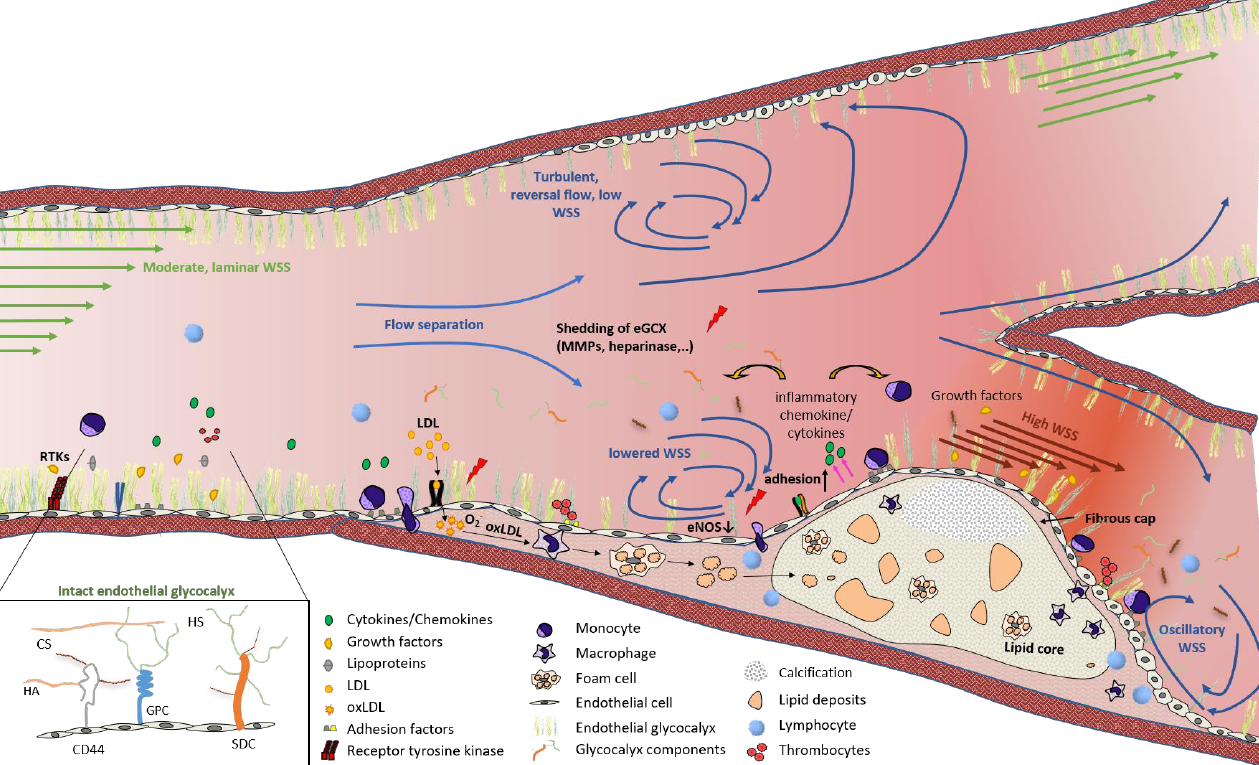
Figure 1. Flow and WSS patterns at arterial bifurcations, leading to endothelial dysfunction and atherosclerotic plaque development. In straight vessel segments, physiological WSS with laminar flow leads to a quiescent EC phenotype with an intact eGCX. At bifurcation sites, flow separation causes turbulent and reversal flow with lowered WSS at the outer vessel wall and the plaque shoulder regions, whereas high WSS occurs at the throat of the plaque. These different flow patterns and the resulting WSS gradient result in eGCX degradation and endothelial dysfunction, characterized by the induction of inflammatory signaling cascades, hence further promoting plaque progression. CS: chondroitin sulfate, GPC: glypican, HA: hyaluronic acid, HS: heparan sulfate, RTK: receptor tyrosine kinase, SDC: syndecan.